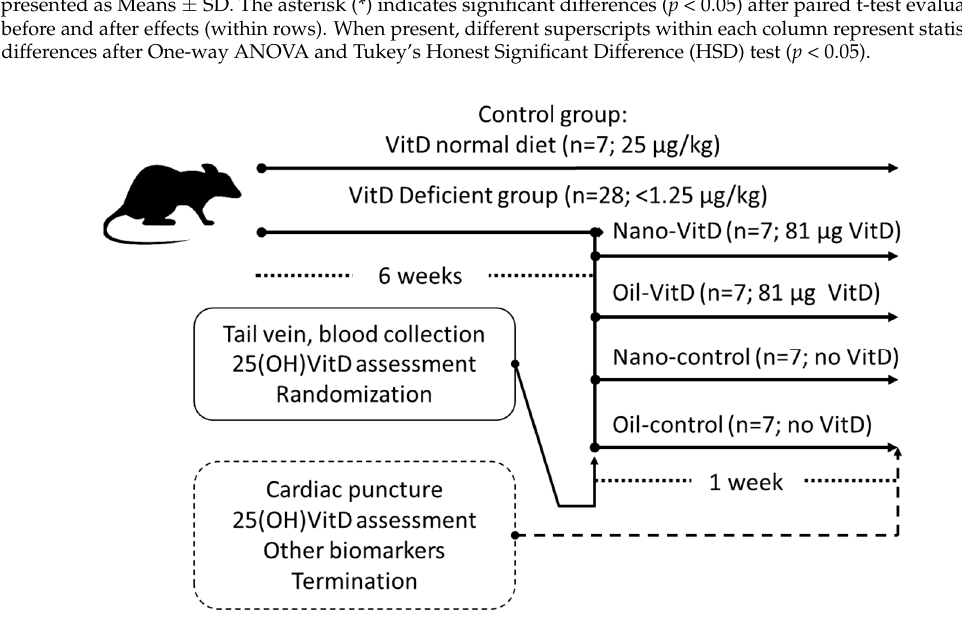
Figure 1. Study experimental design.